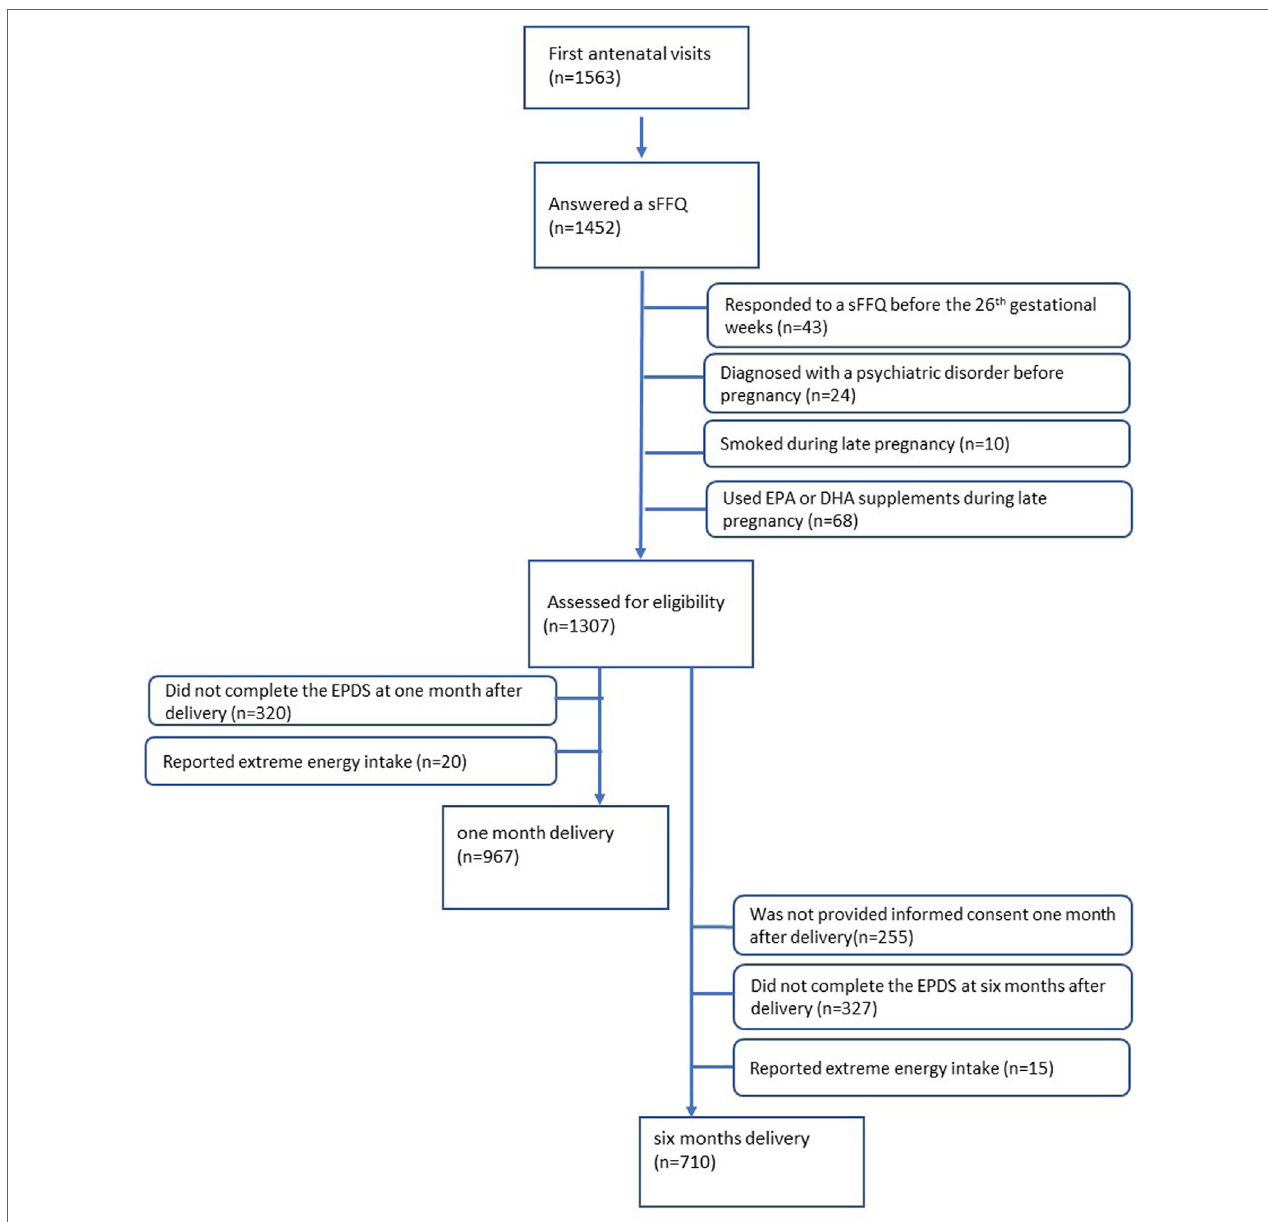
FigUre 1 | Subject flow